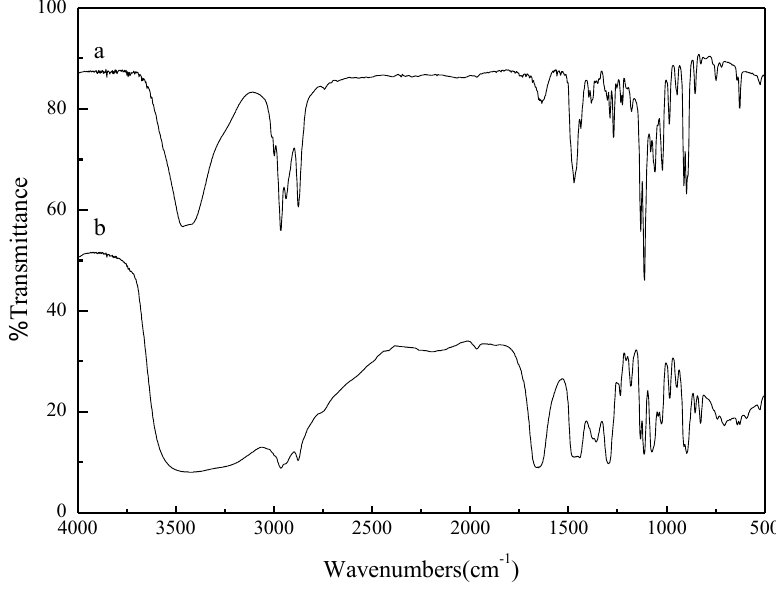
Figure 1. FT-IR of ionic liquids intermediates [Hnmm]Br and ionic liquids